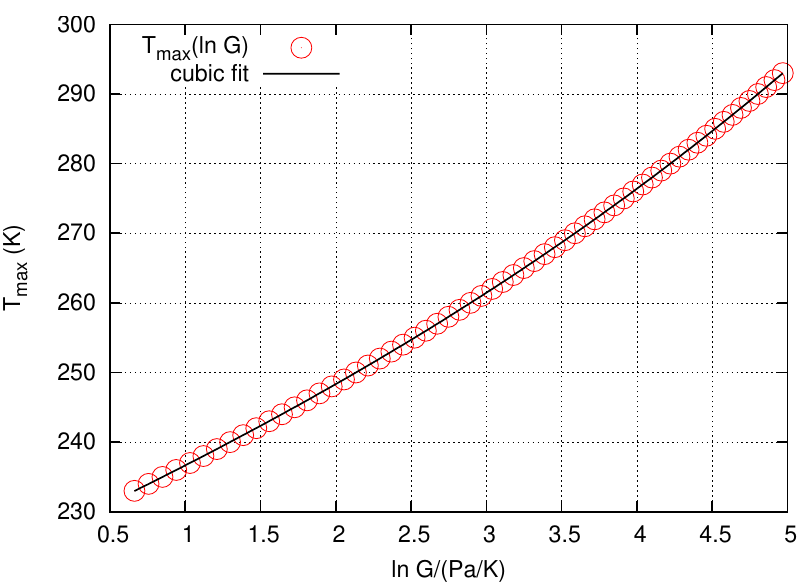
Figure 1. Dependence of the maximum temperature at which contrails are possible, T max , on the logarithm of G for values of G exceeding 2 PaK − 1 , which are typical for fuel cell exhausts. The red circles represent the values from the Clausius-Clapeyron equation, the black solid line represents the cubic